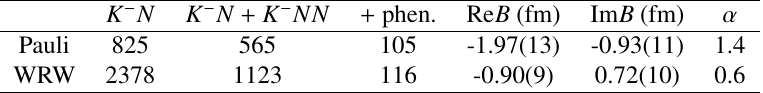
Table 3. Values of χ 2 (65) resulting from the comparison of the calculations of kaonic atoms using K − N , K − N + K − NN , and K − N + K − NN + phen. multi-nucleon potentials based on the Pauli blocked and WRW modified BCN amplitudes with the experimental data. Values of complex amplitude B and parameter α are presented as well. K − N K − N + K − NN +